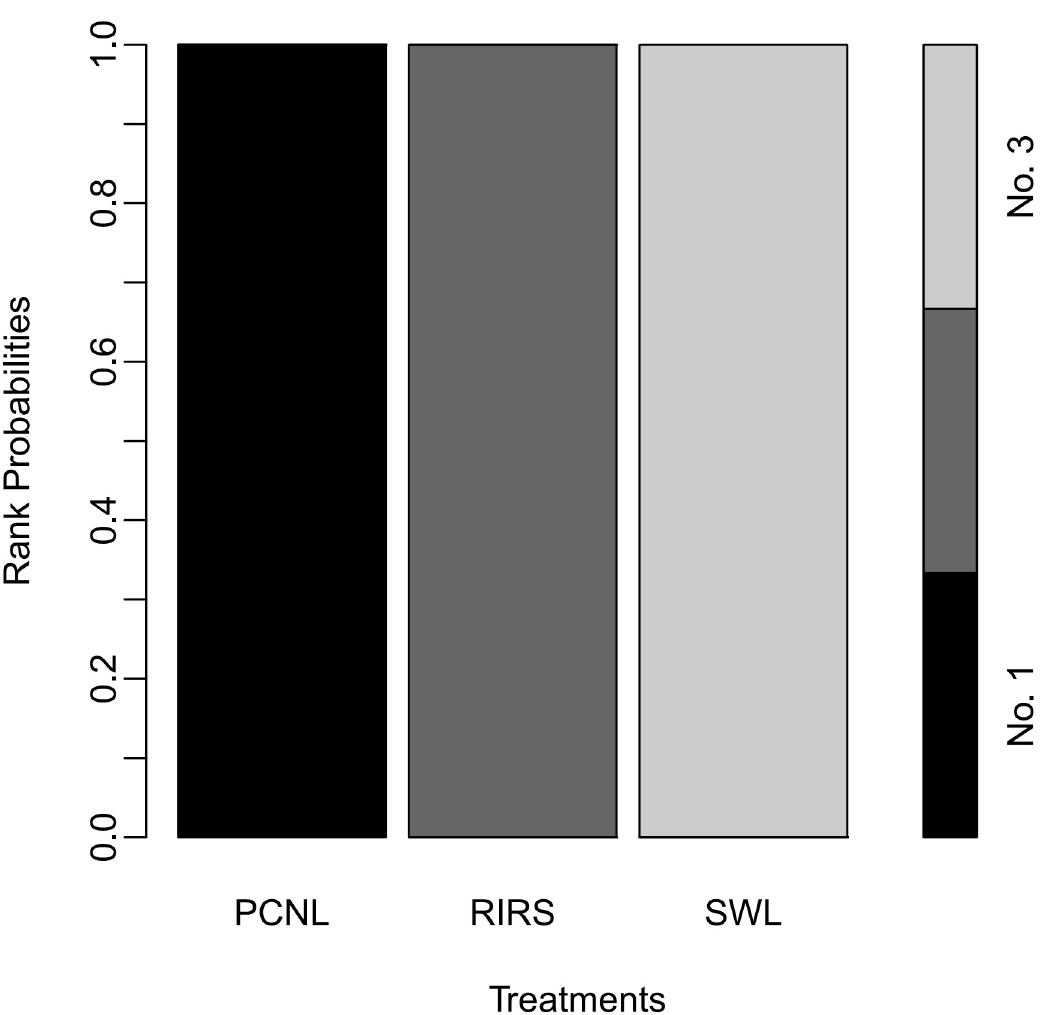
Fig 11. Rank-probability test of network meta-analyses. In the rank-probability test, PCNL was ranked as No. 1 and SWL was ranked as No.